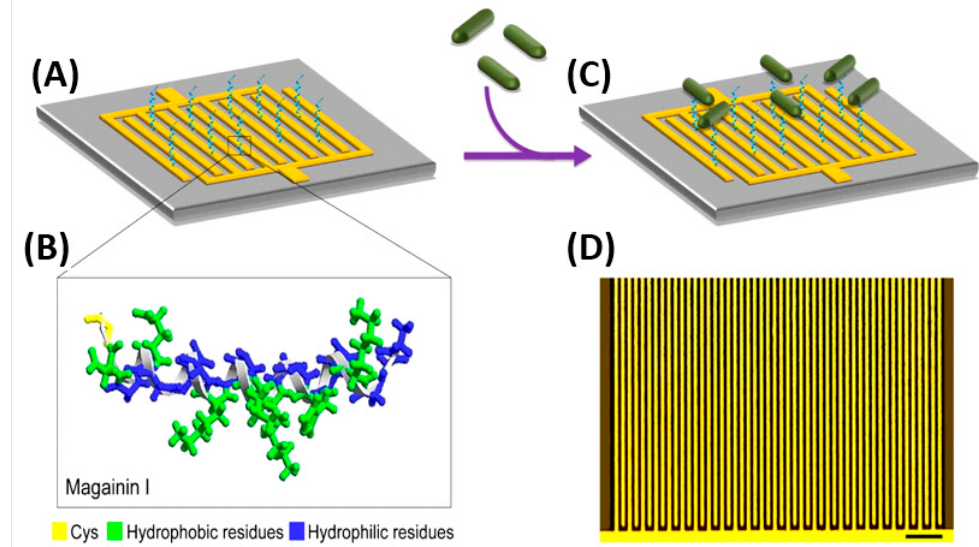
Figure 5. ( A ) Schematic impedimetric set up of Magainin I immobilized on an interdigitated micro- electrode array. ( B ) Magainin I in helical form, modified with a terminal cysteine residue and with clearly defined hydrophobic and hydrophilic faces. ( C ) Detection of bacteria achieved via binding of target cells to the immobilized AMPs. ( D ) Optical image of the interdigitated microelectrode array (scale bar: 50 μ m) [120]. Copyright 2010, National Academy of Sciences.